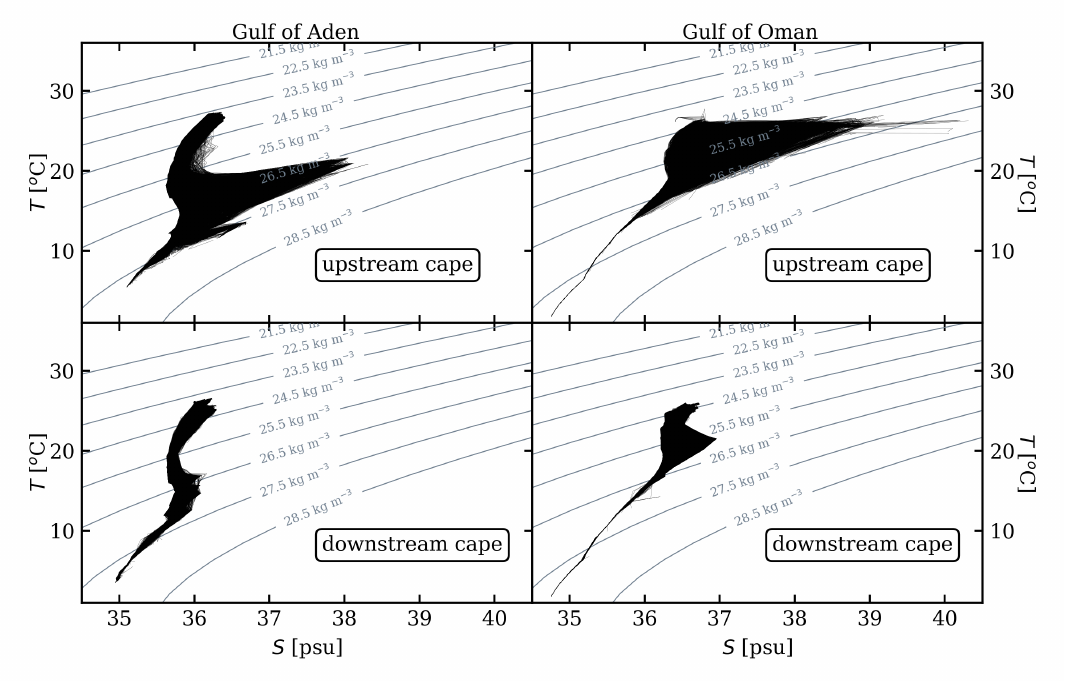
Figure 13. T/S diagram ( left ) in the Gulf of Aden and ( right ) in the Gulf of Oman, ( top ) upstream and ( bottom ) downstream of the cape. Density contours are drawn as solid gray